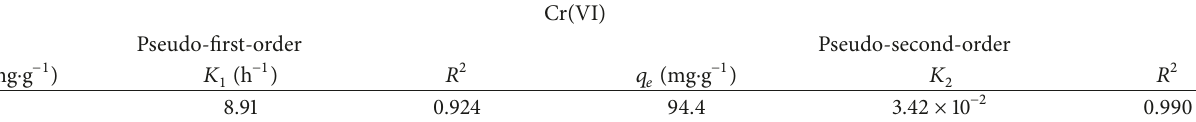
Table 3: The kinetic coefficient for Cr(VI) using hybrid membrane of carboxymethyl chitosan and silicon dioxide.